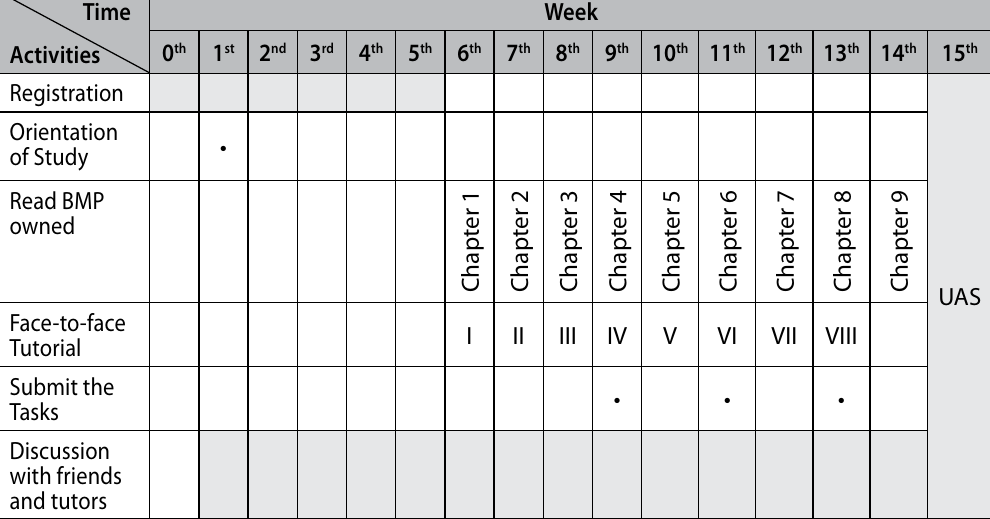
Table 3 The learning process of PGSD student by semester Source: Academic Calendar 2012 of Universitas Terbuka